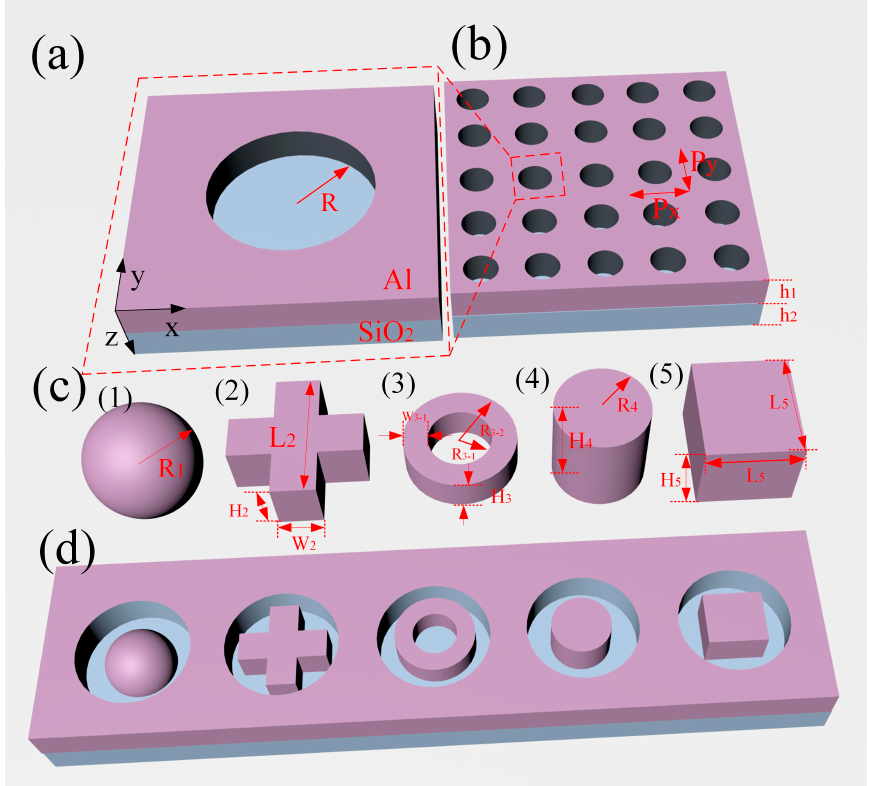
Figure 1. ( a ) Structural cross-sectional diagram of the unit structure in the X–Y plane. R represents the circle structure radius; h 1 and h 2 are the thickness of the Al and SiO 2 ; P x and P y are the periods; as follows: R = 90 nm; h 1 = 50 nm; h 2 = 100 nm; P x = P y = 200 nm. ( b ) Cross-sectional diagrams of the periodic circle structure arrays. ( c ) Different nanoparticles: Sphere, Cross, Torus, Cylinder and Cube—they are all made of aluminum. ( d ) Schematic of the template structure filled with different